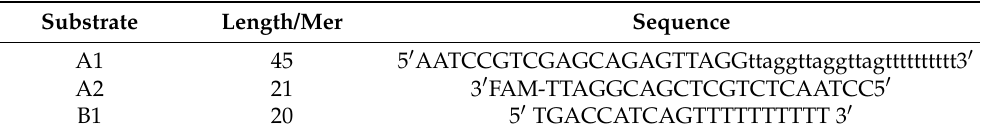
Table 2. Oligonucleotide sequences of the substrates. Substrate Length/Mer